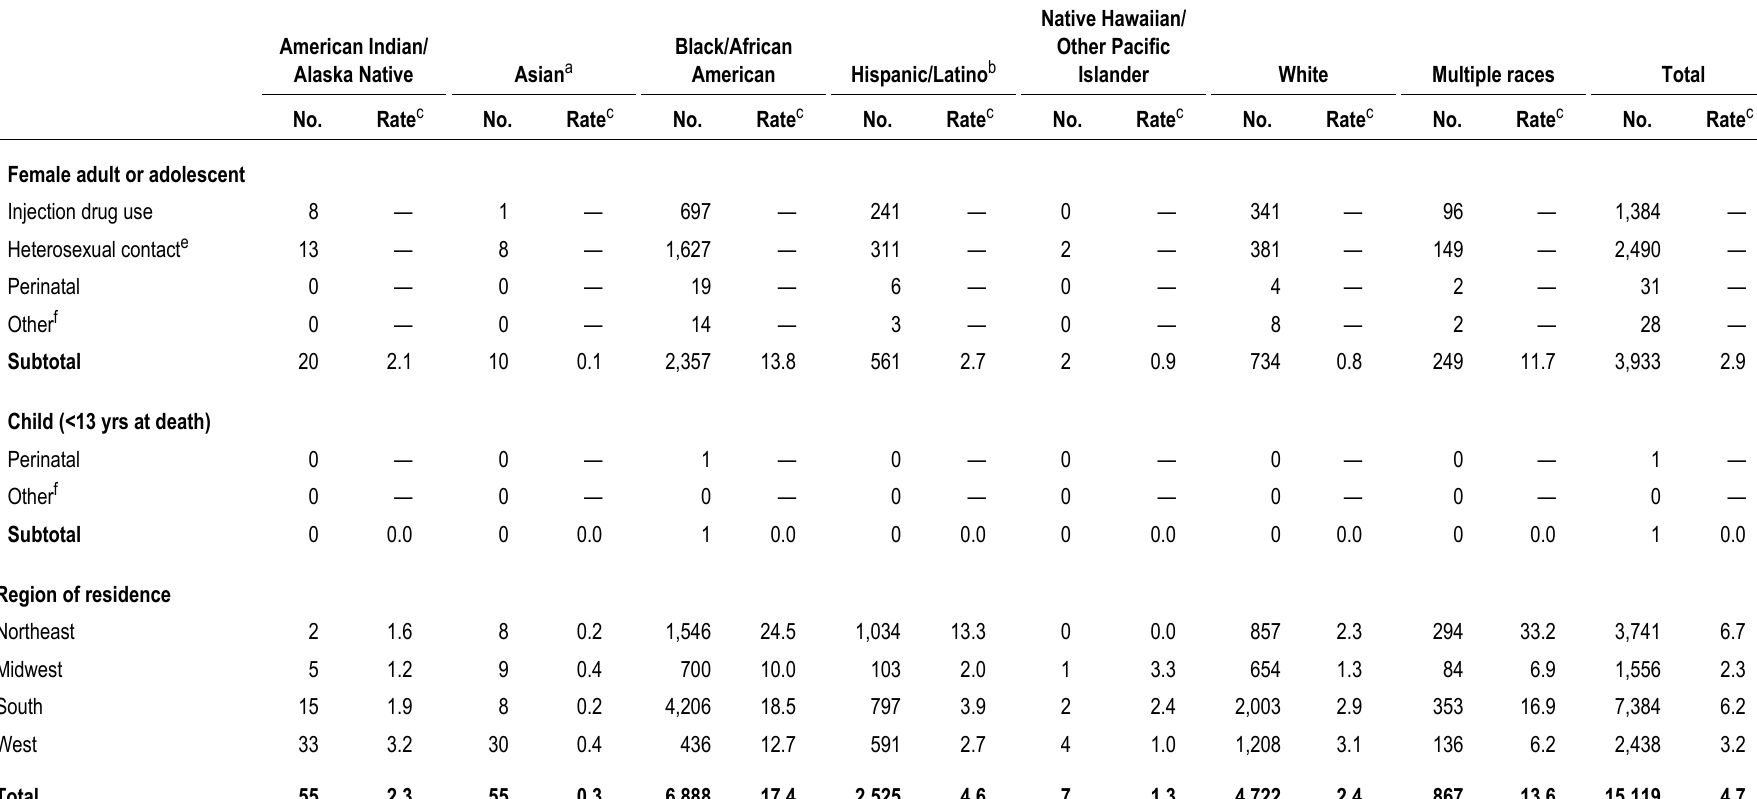
Table 14a. Deaths of persons with diagnosed HIV infection, by race/ethnicity and selected characteristics, 2014—United States (cont) Native Hawaiian/ American Indian/ Black/African Other Pacific Alaska Native Asian a American Hispanic/Latino b Islander White Multiple races Total No. Rate c No. Rate c No. Rate c No. Rate c No. Rate c No. Rate c No. Rate c No. Rate